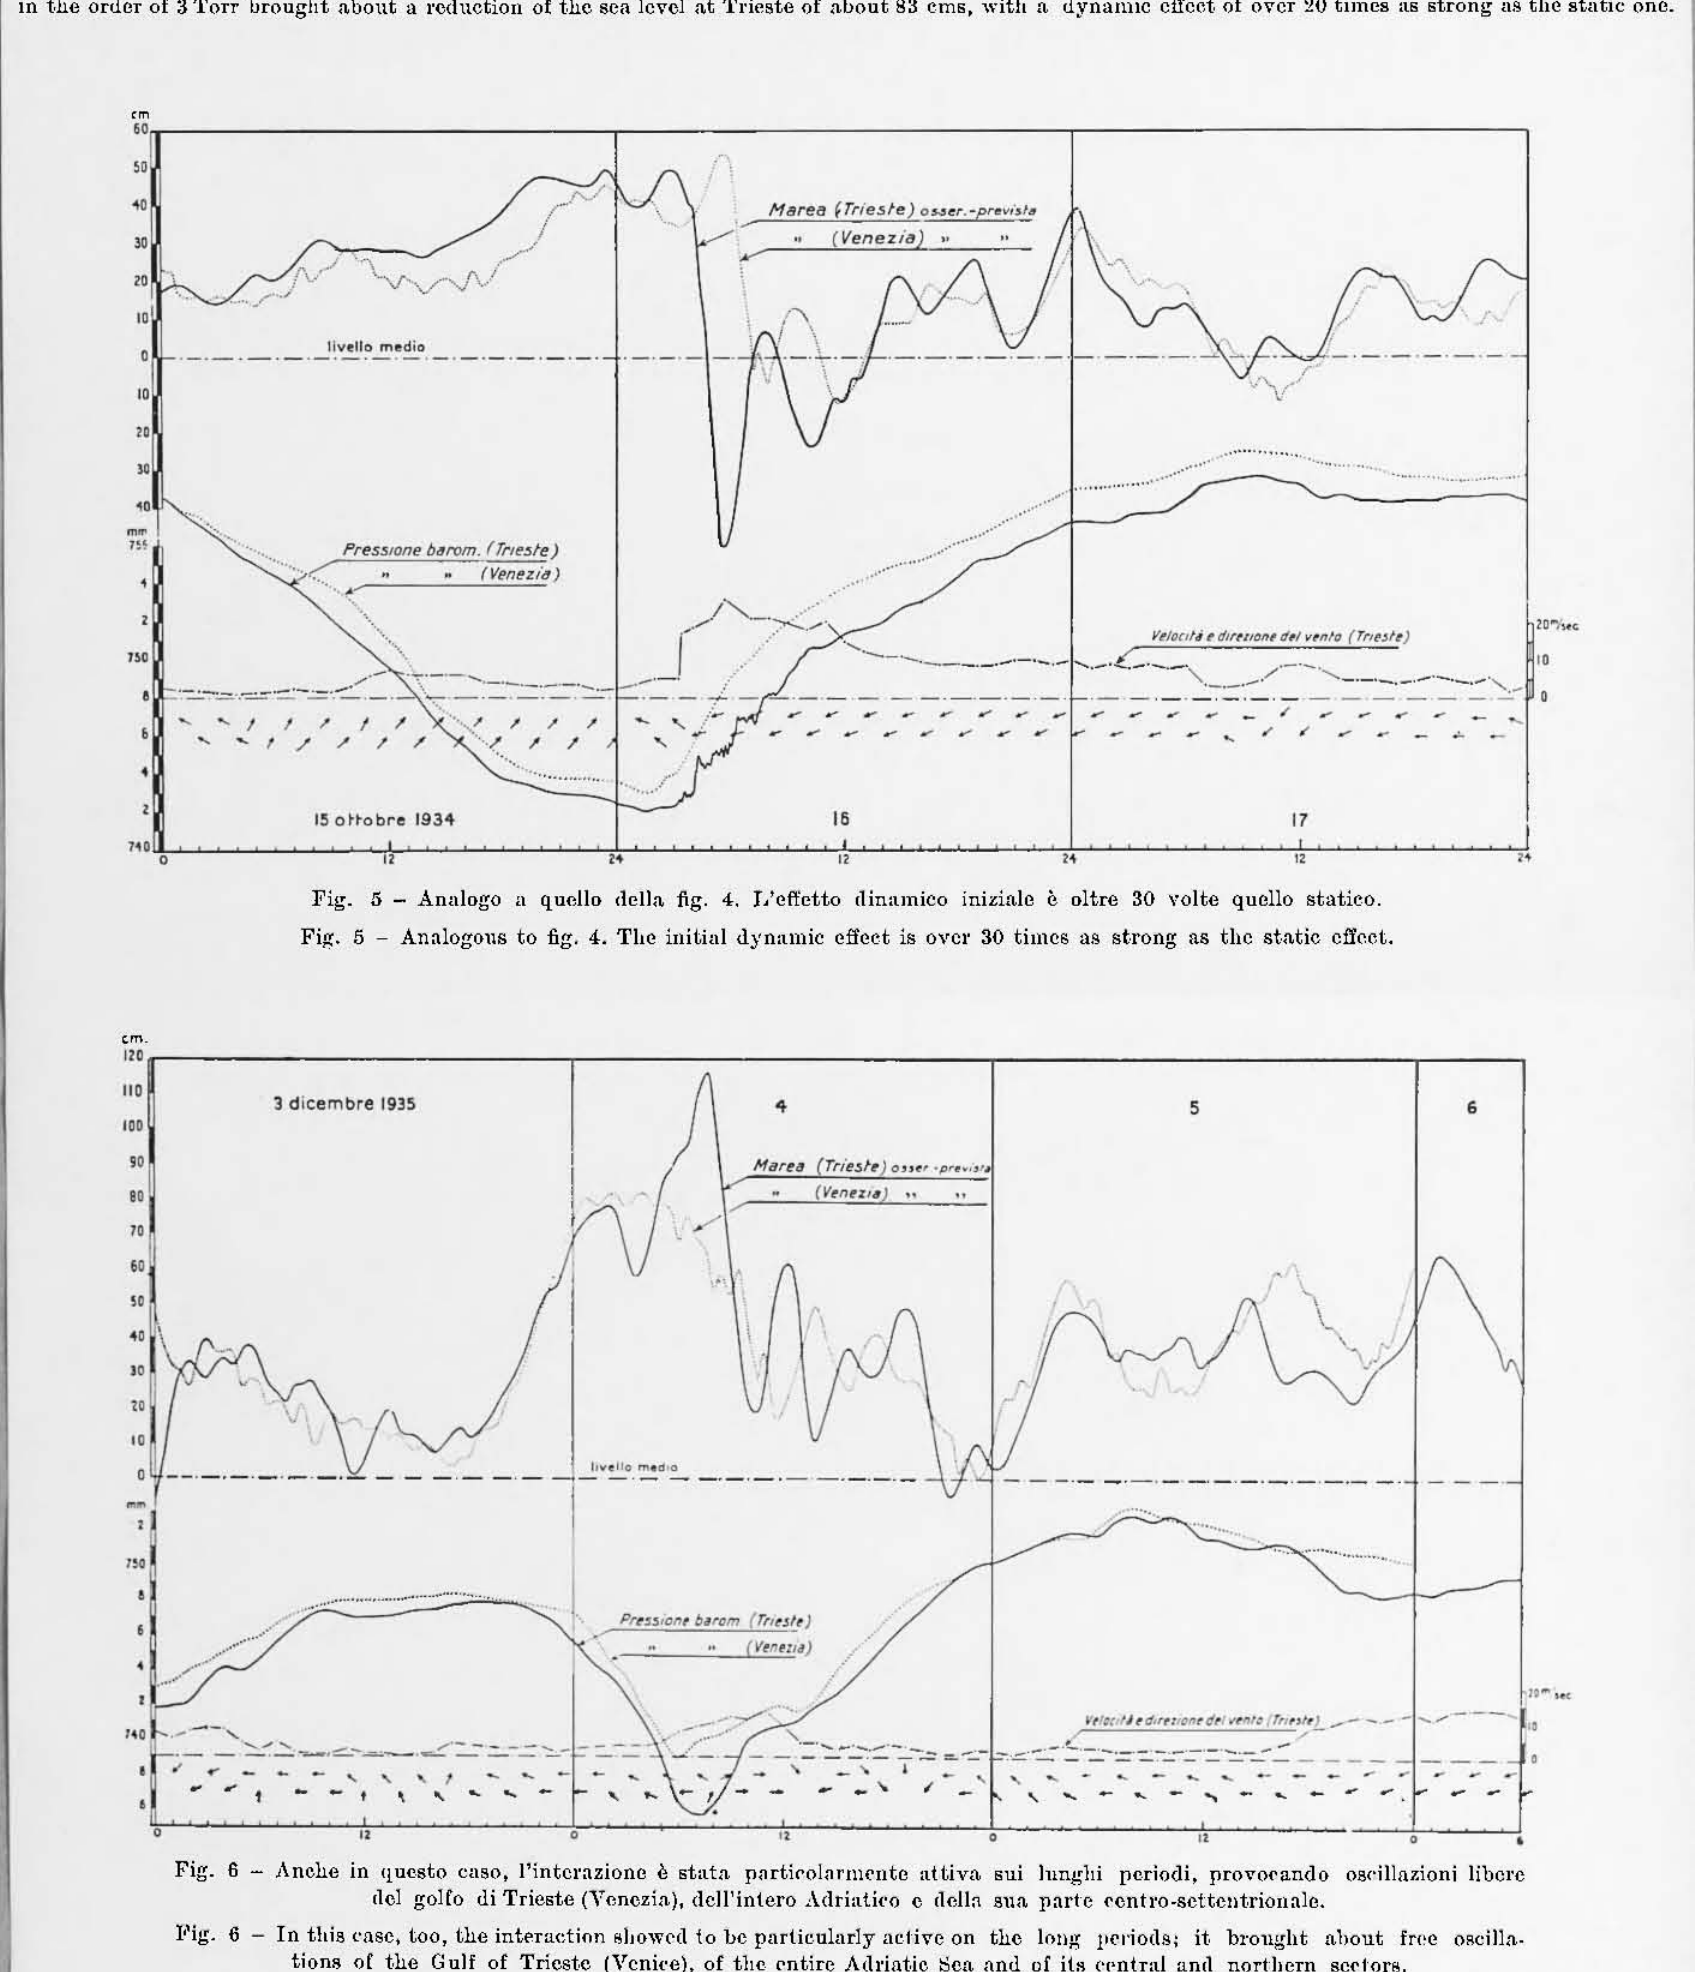
Fig. 5 - Analogo a quello della fig. 4. L'effetto dinamico iniziale è oltre 30 volte quello statico. Fig. 5 - Analogolls to fig, 4. The initial ùynamie eHect is over 30 times as st.rong as the sttJ.tie efIcct.